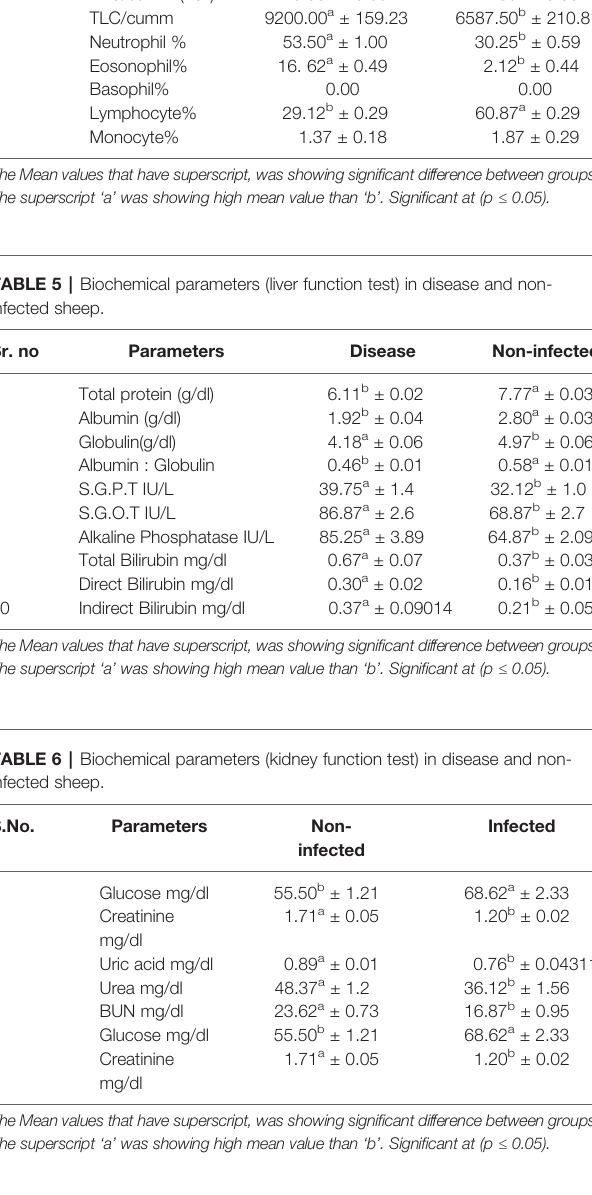
TABLE 4 | Haematological parameters in disease and non-infected sheep.